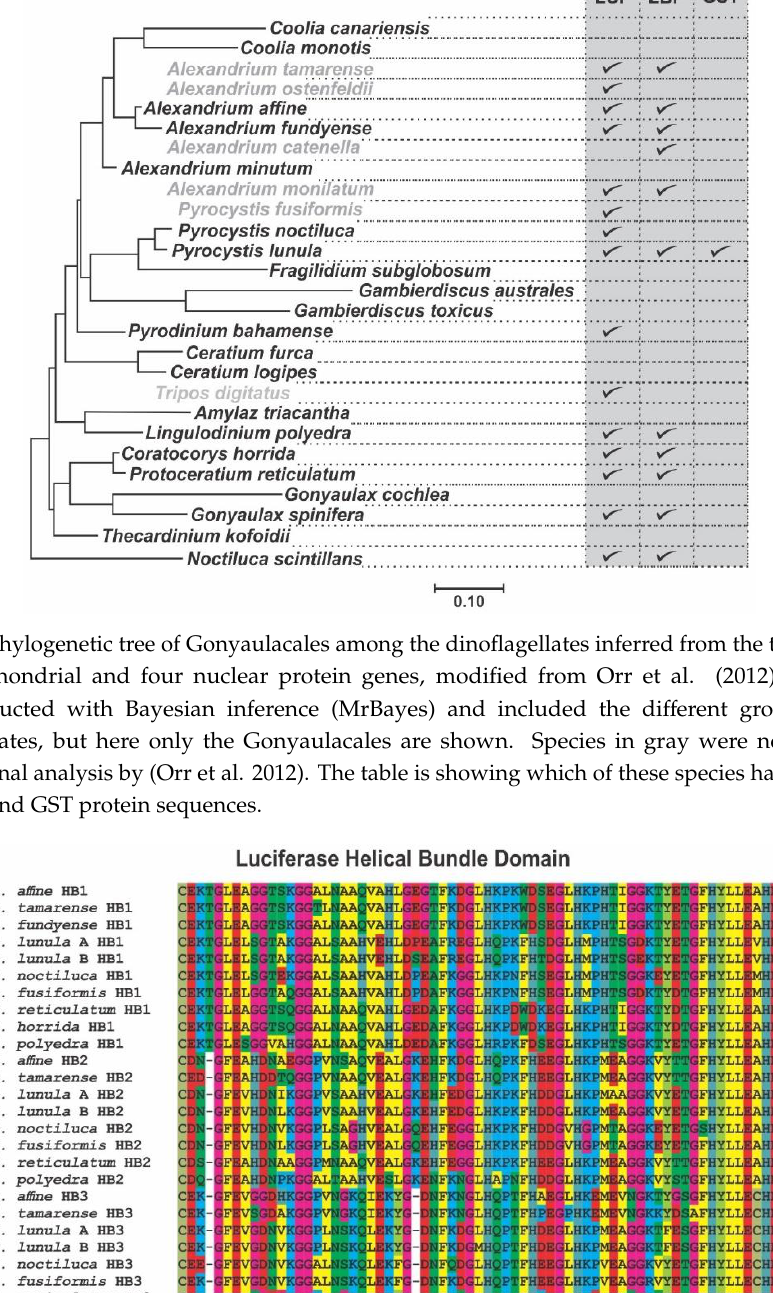
Figure 6. Sequence alignment of the three LCFs helical bundle domains contained in species of the genera Alexandrium , Lingulodinium , Ceratocorys , Pyrocystis and Protoceratium that have their protein